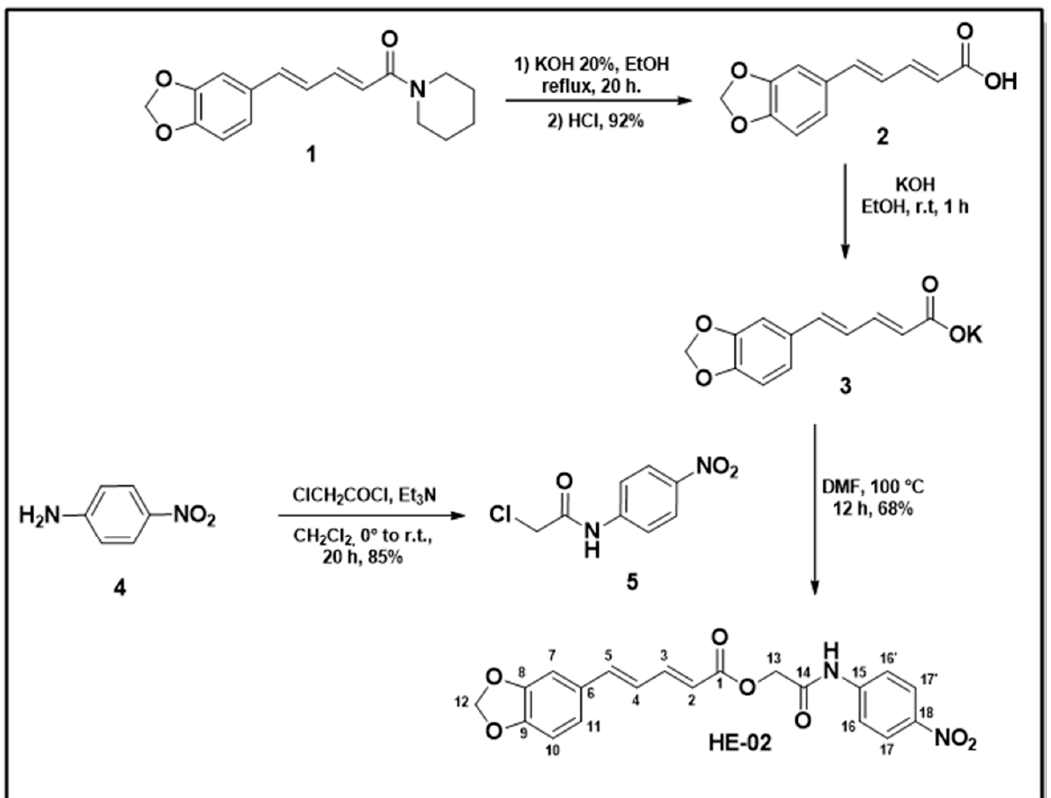
Scheme 1. Synthesis of the compound N -(p-nitrophenyl)acetamide piperinoate (HE-02). Piperine 1 was obtained by the ethanolic extraction of the ground black pepper ( P. nigrum ) seed in yield ranging from 3–7% [1]. Piperinic acid 2 was obtained from piperine 1 in 92% yield by basic hydrolysis [1]. A neutralization reaction was carried out with piperinic acid 2 in an ethanolic solution of potassium hydroxide, thereby obtaining the potassium piperinoate 3 in high yield. The 2-chloro- N -(4-nitrophenyl)acetamide 5 compound was obtained in N -acetylation reaction between 4-nitroaniline 4 and 2-chloroacetyl chloride [2]. Reaction between the potassium salt of piperinic acid 3 with 2-chloro- N -(4-nitrophenyl)acetamide 5 in N , N -Dimethylformamide (DMF) provided the formation of N -(p-nitrophenyl)acetamide piperinoate HE-02 in yield of 60%. The structure of N -(p-nitrophenyl)acetamide piperinoate HE-02 was confirmed by IR, 1 H-NMR and 13 C-NMR spectroscopic techniques, including 2D Nuclear Magnetic Resonance (NMR) analysis (HMQC). The spectrum in the infrared region showed 3296 cm -1 absorption relative to the bond of the N-H group. The subject compound exhibits striking characteristics of ester and amide spectra, which are the absorptions of the strong C=O functional group appearing in 1678 cm − 1 . The C–O–C stretch bands appearing in 1246 cm − 1 and C–O stretching in 1174 and 1091 cm − 1 . The C=C stretching 1 H-NMR spectrum revealed two intense singlets, one with an integral for two hydrogens relating to H-13 at δ 4.81 ppm and the other with an integral for two hydrogens referring to H-12 at δ 6.05 ppm.